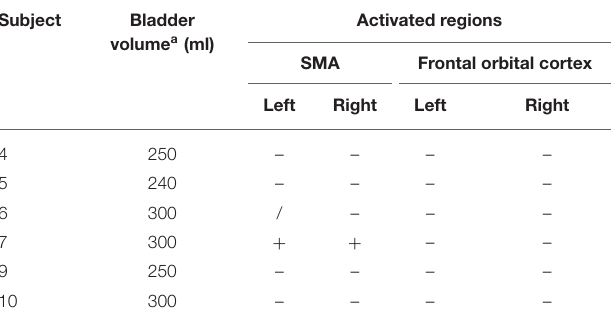
TABLE 3 | Regions responding to neobladder voluntary continence in single-subject